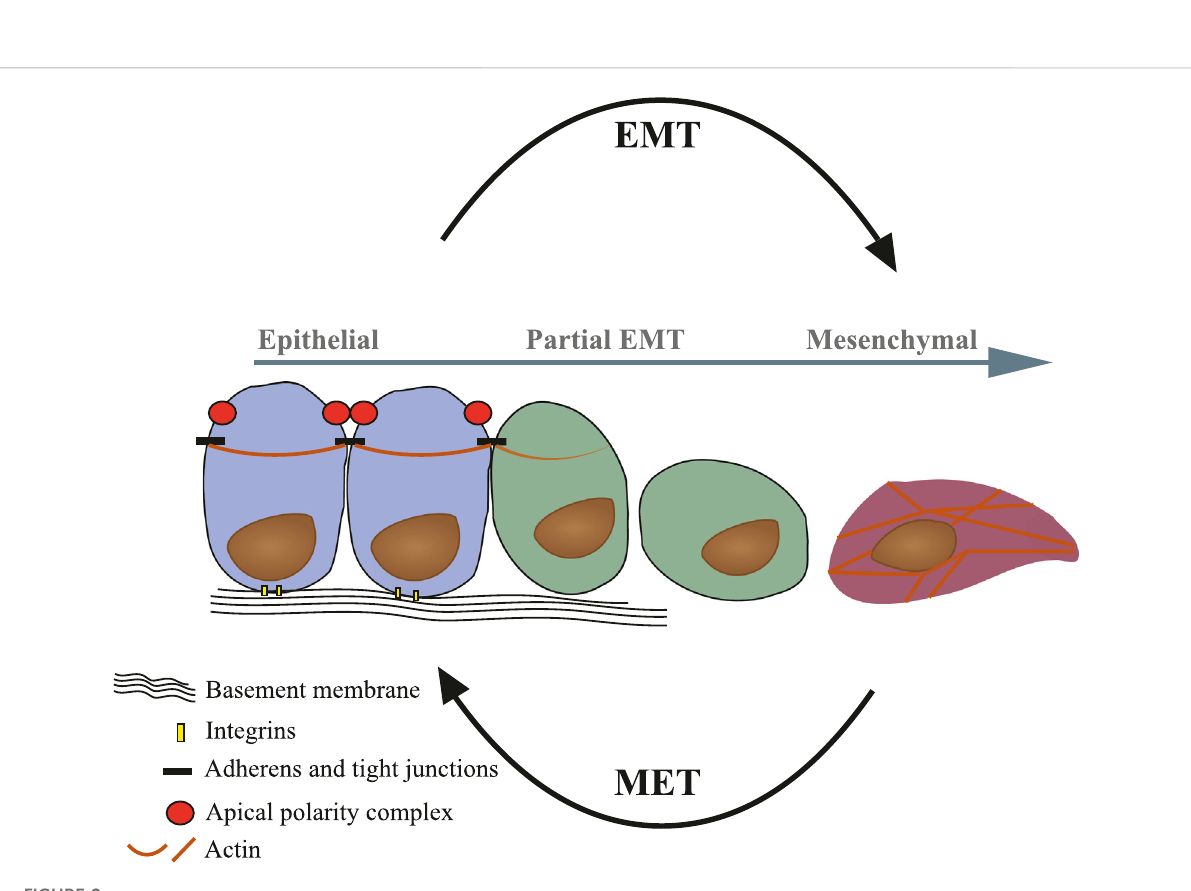
FIGURE 2 Representation of structural and cellular changes during EMT/MET. Epithelial cells (blue) exhibit apical-basal polarity and cortical actin organization. Epithelium comprises tightly packed and functionally synchronized epithelial cells connected to each other via cell-cell junctions and are anchored to the basement membrane via integrins. Upon EMT, cells lose epithelial characteristics and become dedifferentiated single cells (partial EMT — green). The full conversion gives rise to mesenchymal-like cells (purple) with front-rear polarity and actin stress fi bers